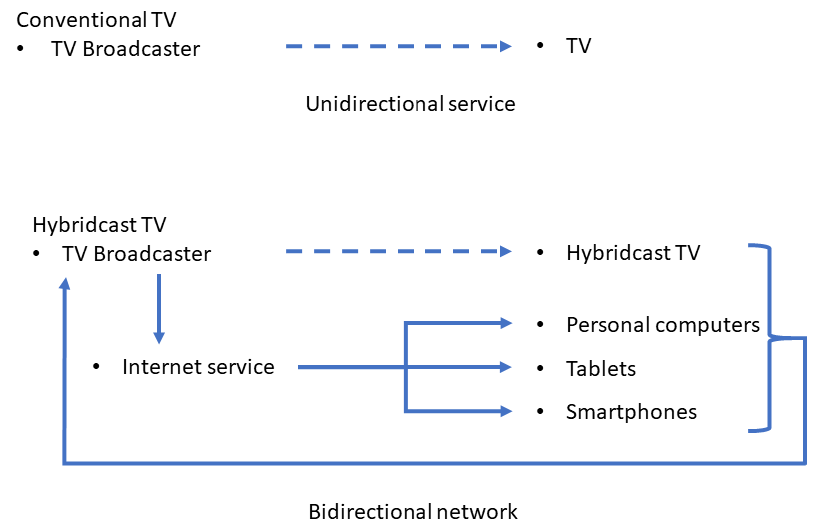
Figure 1. Overview of conventional TV and Hybridcast TV. Solid lines indicate bidirectional inter- action between television (TV) station and audiences through the Internet. Dashed lines indicate broadcasts from the TV station to audiences over airwaves.